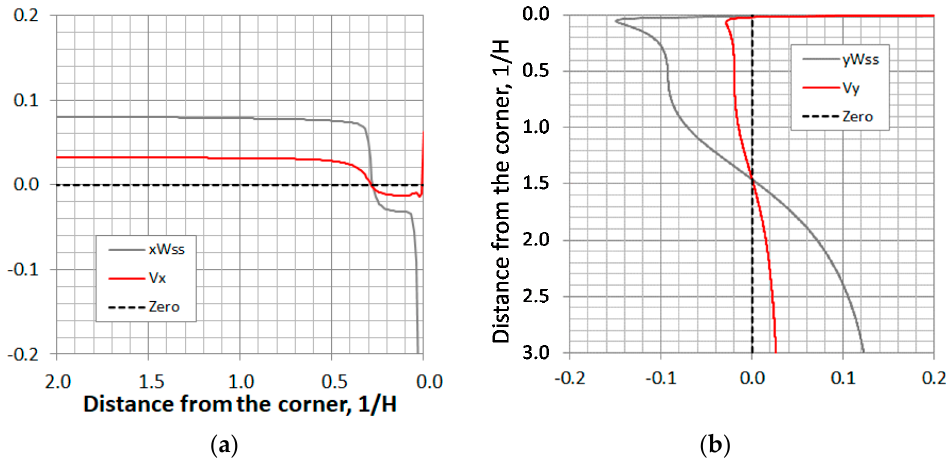
Figure A3. Normalized wall shear stress and streamwise velocity near the wall in the vortex region: ( a ) elastic vortex (xWss and Vx) for Wi = 1.0, El = 100, β = 0.1; ( b ) inertial vortex (yWss and Vy) for Re = 100.